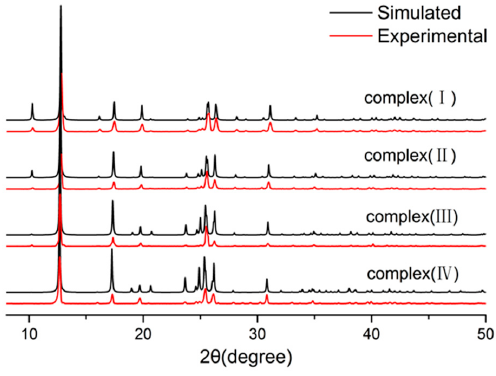
Figure 3. Powder X-ray diffraction patterns for (I), (II), (III), and (IV).